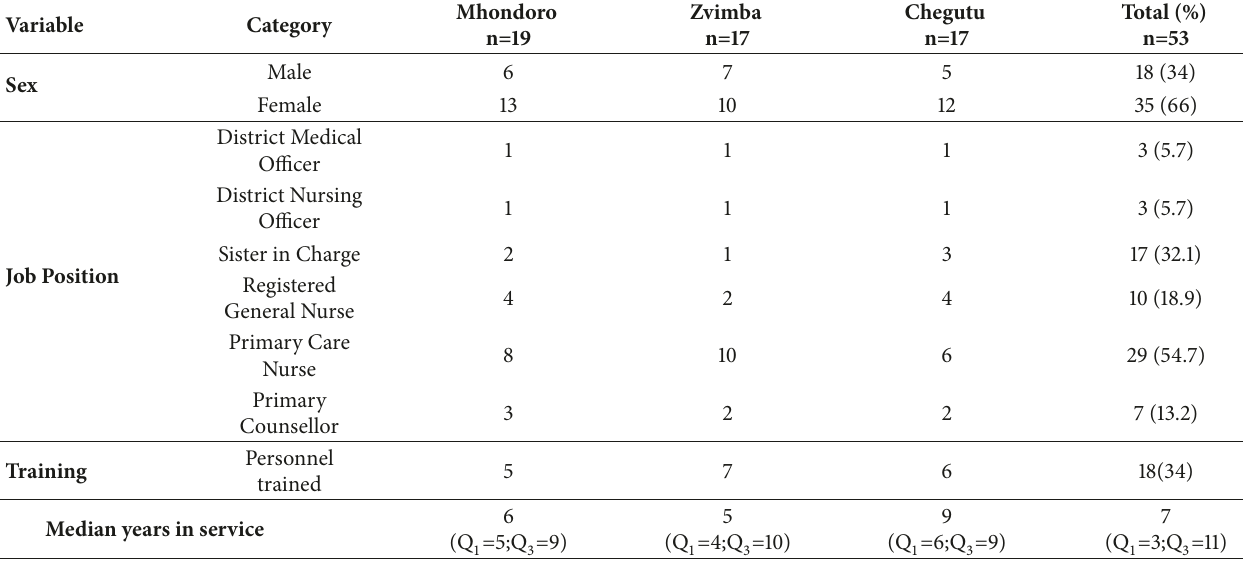
Table 1: Demographic Characteristics of participants, Mhondoro, Zvimba, and Chegutu districts, Mashonaland West Province, 2017.